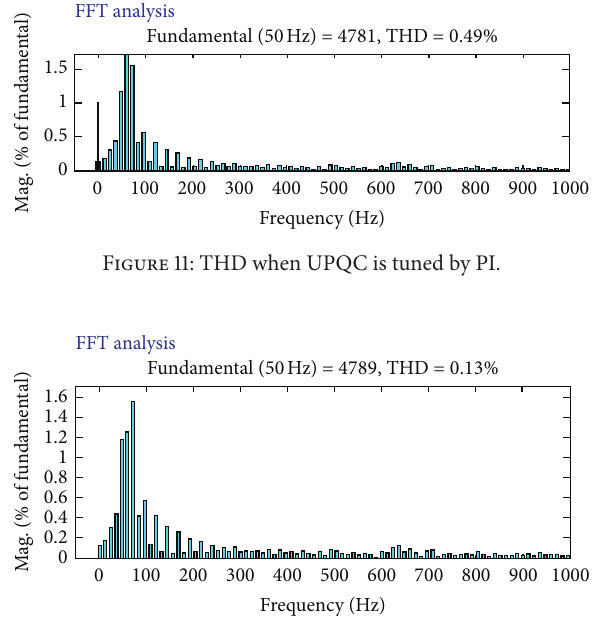
Figure 12: THD when UPQC is tuned by ACO-FLC